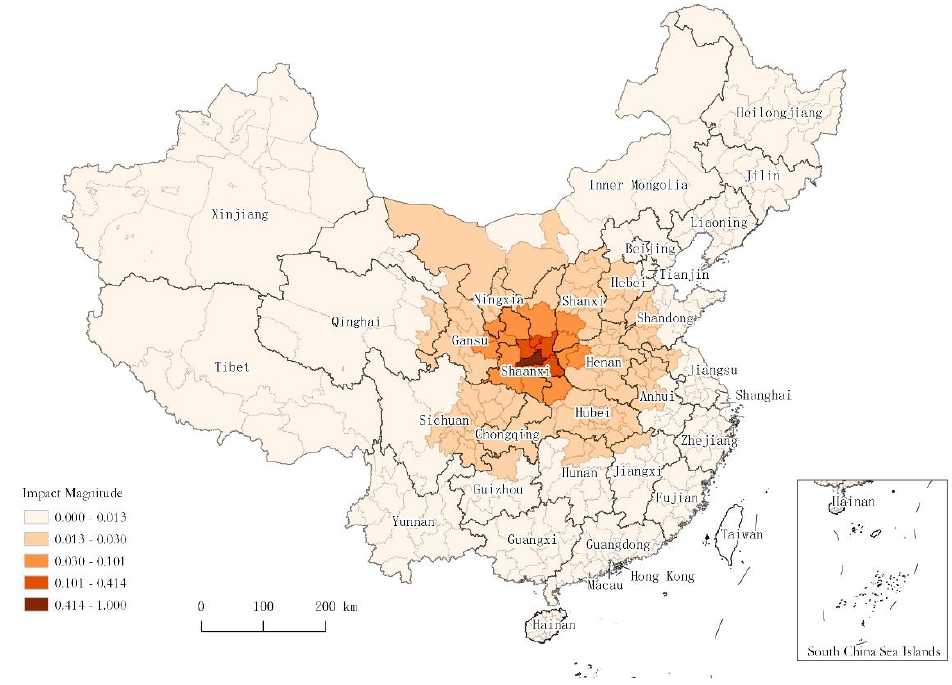
Figure 3. Influence scope of localized epidemic events in Xi ’ an.